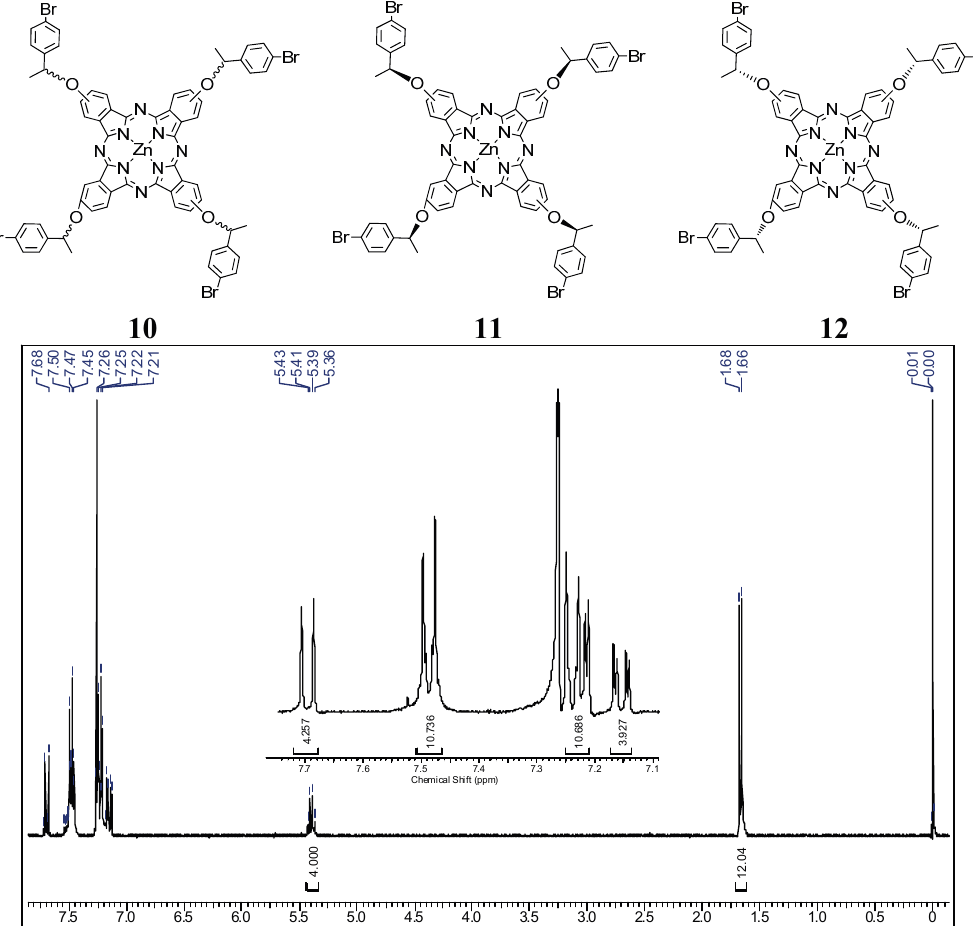
Figure 1. Chemical structure of all synthesized macrocycles and the 1 H-NMR spectrum of phthlalocyanine 10 in DMSO- d 6